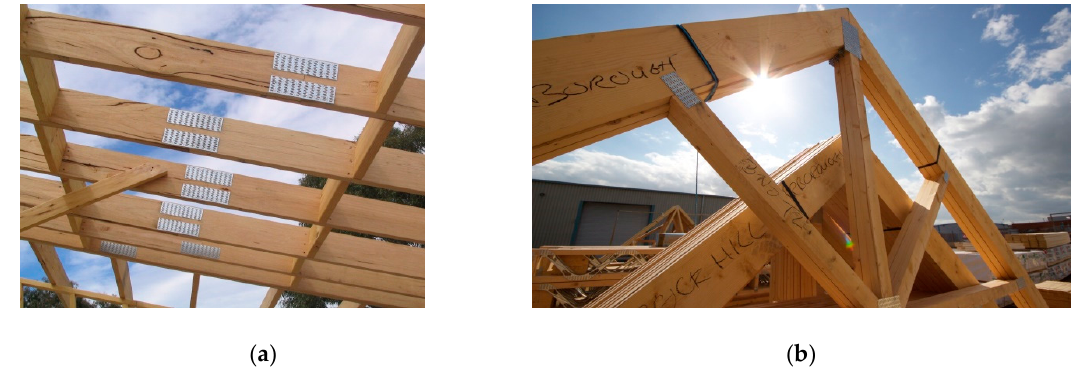
Figure 16. Examples of connections made with nail-plates [51,52].